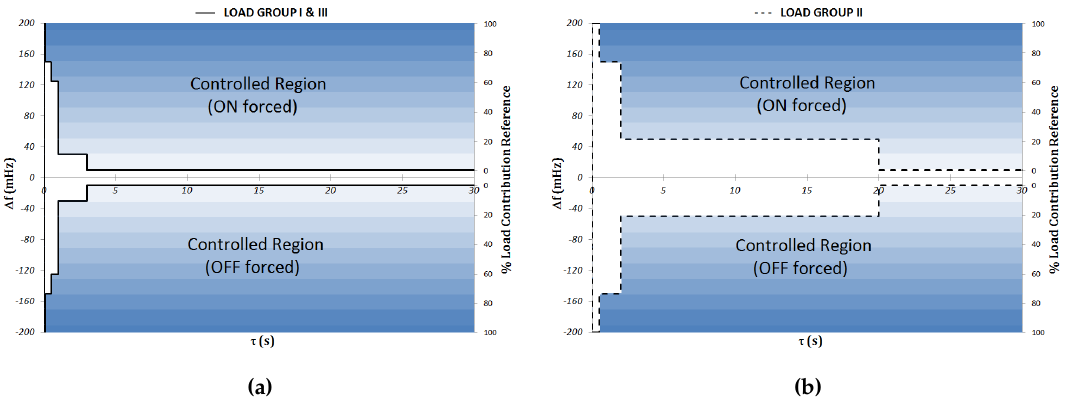
Figure 7. Frequency responsive load controller: ∆ f – τ characteristics. ( a ) Load Groups I and III; ( b ) Load Group